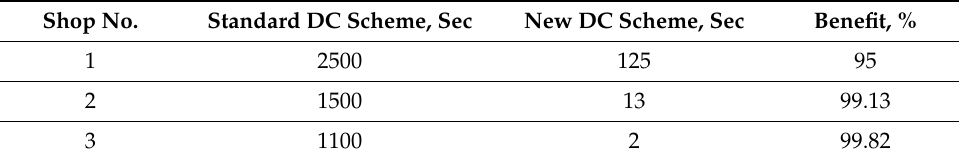
Table 6. Aggregate data on the timeliness of data for the three shops. Shop